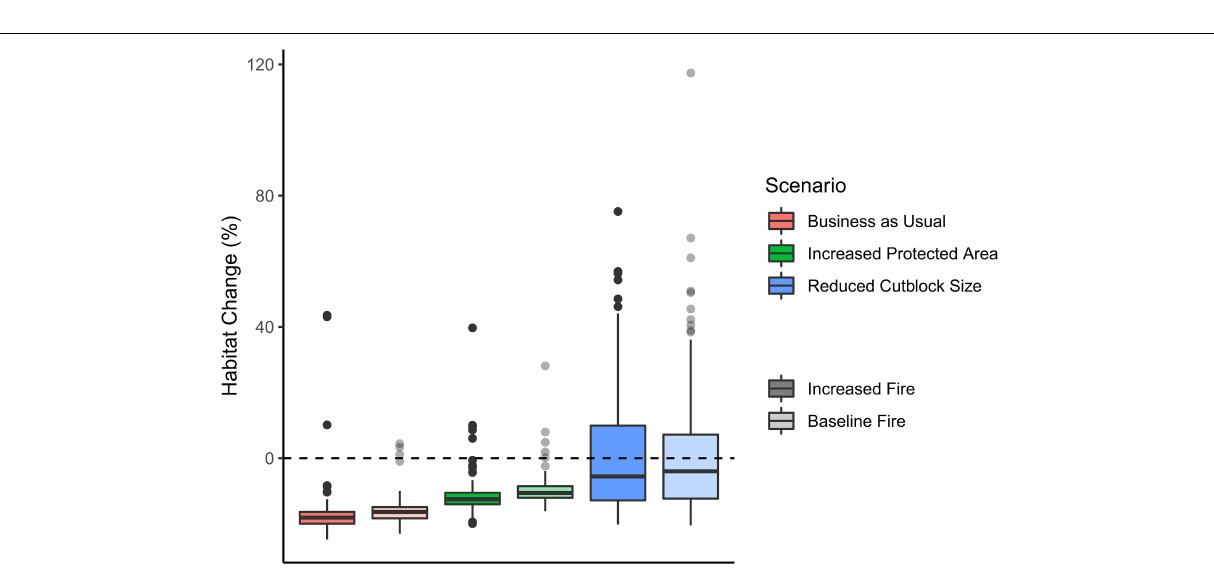
Frontiers in Ecology and Evolution |